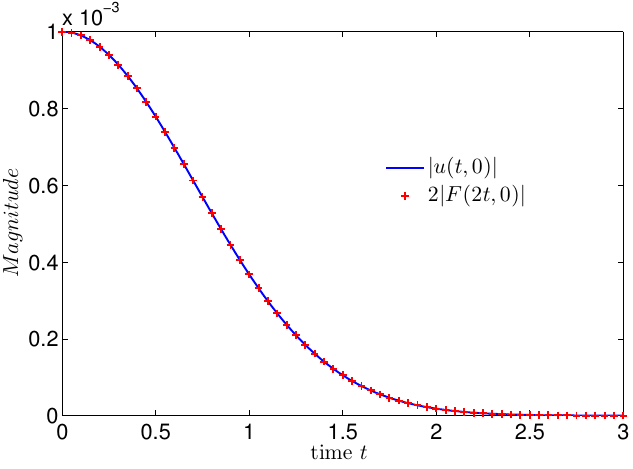
Figure 5. The magnitude of | u ( t ,0 ) | in blue and 2 | F ( 2 t ,0 ) | in